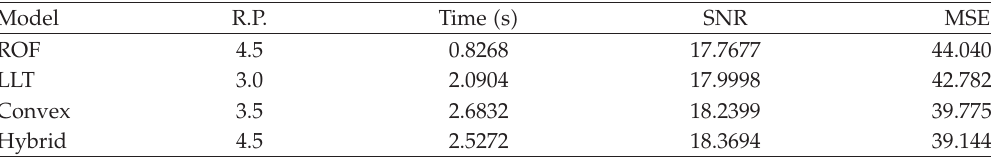
Table 2: The related data in Example 4.8 (cid:3) here R.P. is the regularization parameter (cid:4)